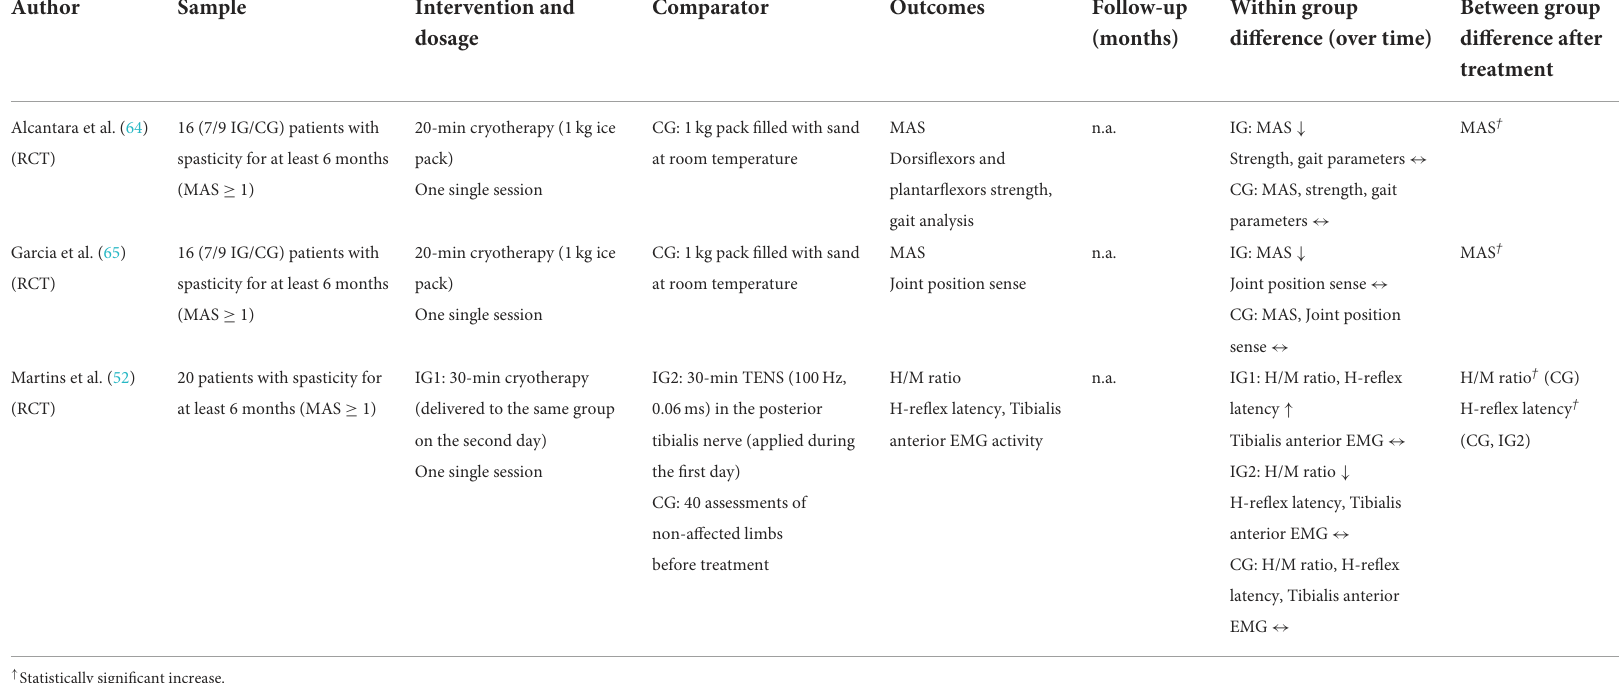
TABLE 8 Characteristics of studies using cryotherapy for the treatment of triceps spasticity after